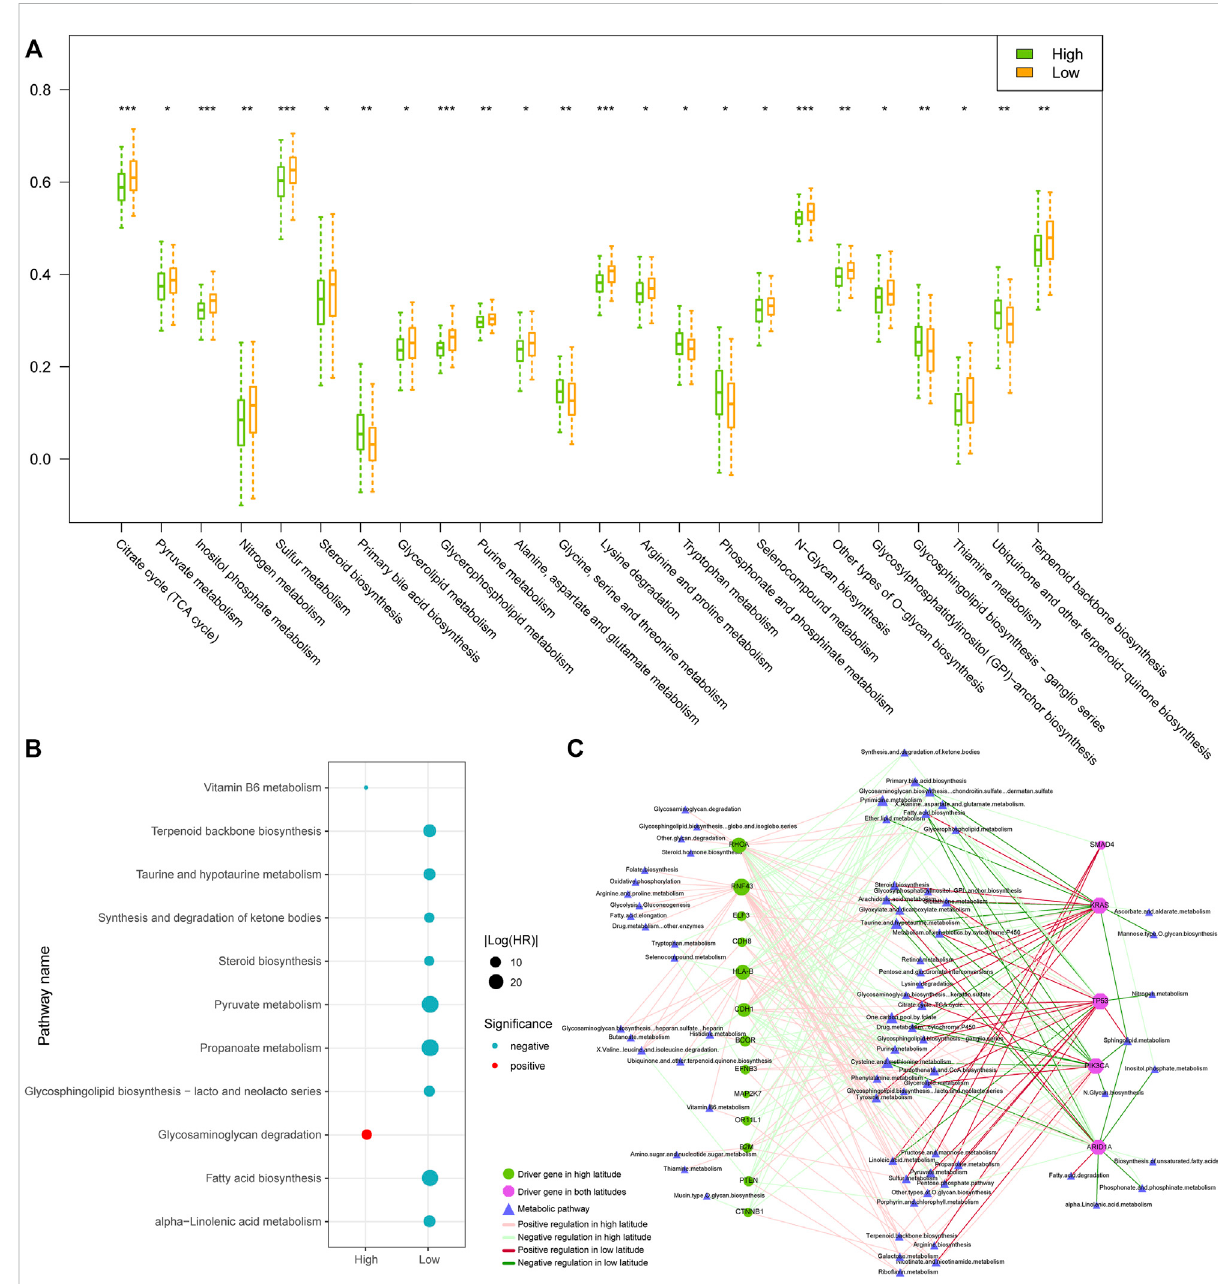
FIGURE 6 Comparisonofsamplesinhighandlowlatitudesatthemetaboliclevel. (A) Metabolicpathwayswithsigni fi cantlydifferentssGSEAactivityscores in two sample groups. (B) Prognostic metabolic pathways. Blue and red dots represented the protective and risk factors, respectively. (C) Driver gene-related metabolic pathway network. The nodes and edges were colored based on the adjacent fi gure